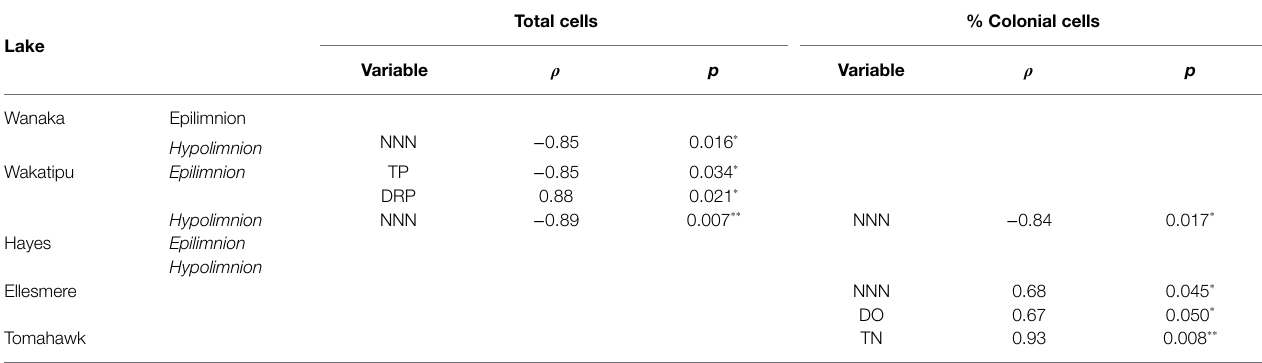
TABLE 3 | Spearman’s rank correlations between total and colonial (as a percentage of total) cell abundances and environmental variables for each lake. Total cells % Colonial cells Lake Variable ρ p Variable